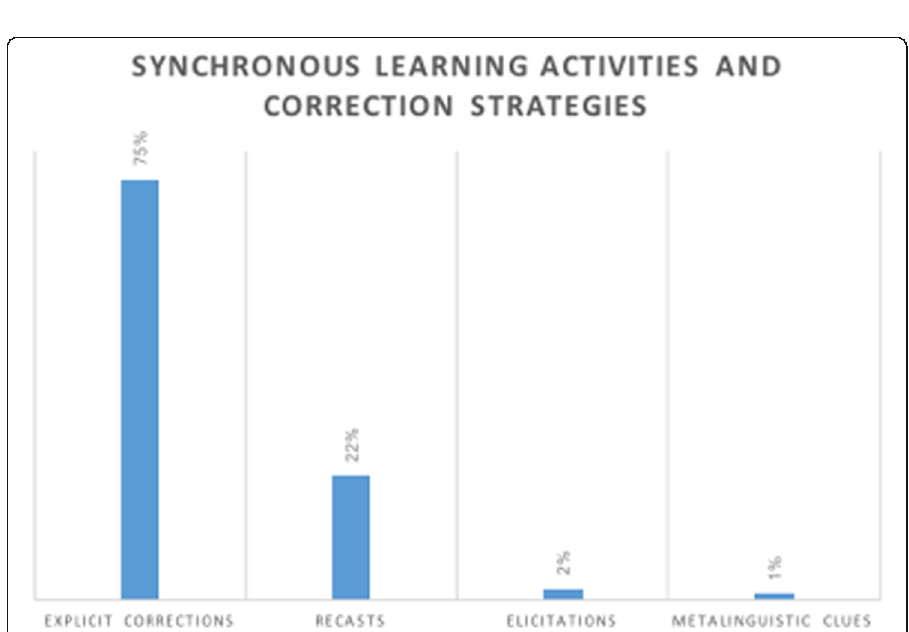
Fig. 4 Corrective feedback in the synchronous learning activities